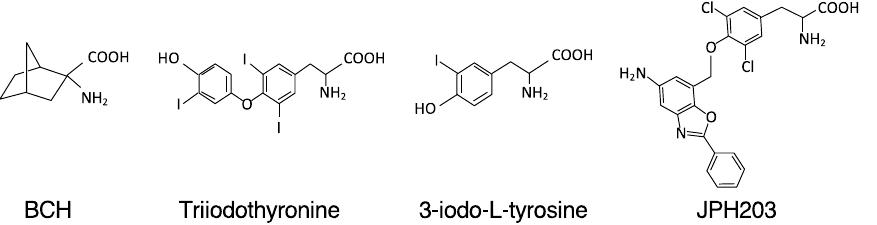
Figure 1. Structures of LAT1 inhibitors. BCH (2-aminobicyclo-(2,2,1)-heptane-2-carboxylic acid) inhibits all L-type amino acid transporters. Triiodothyronine is a thyroid hormone that exerts an inhibitory effect on LAT1. Additionally, 3-iodo-L-tyrosine was identified as a LAT1 inhibitor by comparative modeling and computational screening. JPH203 is a high-affinity LAT1-specific inhibitor.